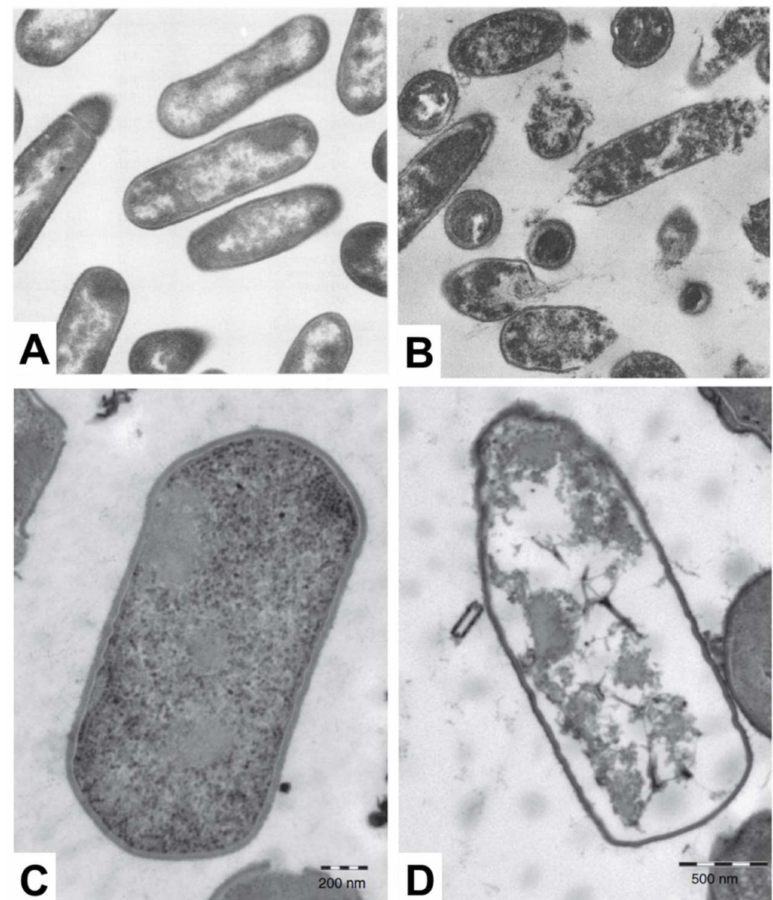
Figure 3. TEM micrographs show the effect of treating bacterial cells with fatty acids and monoglycerides. L. monocytogenes cells that are ( A ) untreated or ( B ) treated with 50 µ g/mL GML (magnification × 44,080) and C. perfringens cells that are ( C ) untreated or ( D ) treated with 1 mg/mL LA. Reproduced with permission from